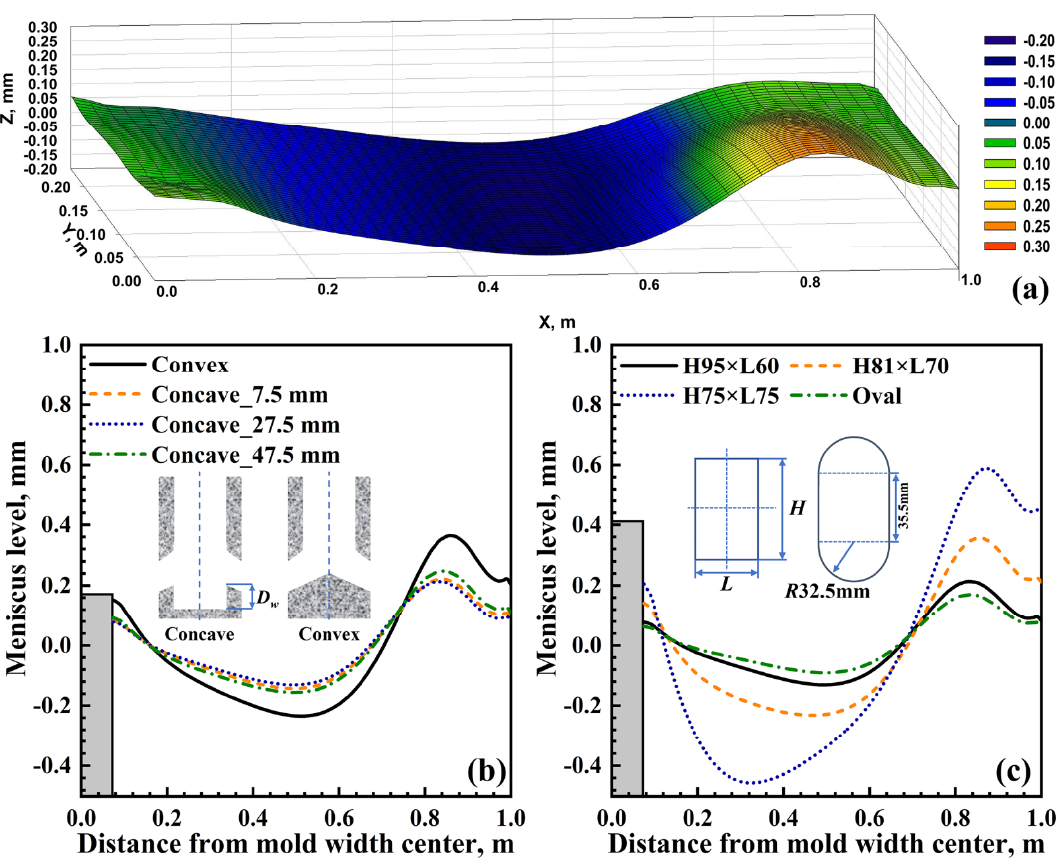
Figure 7. The calculated 3D meniscus level profile for the concave-bottom case with 27.5 mm well depth ( a ) and meniscus level profiles on the mid-thickness plane of the mold under different conditions ( b , c ).